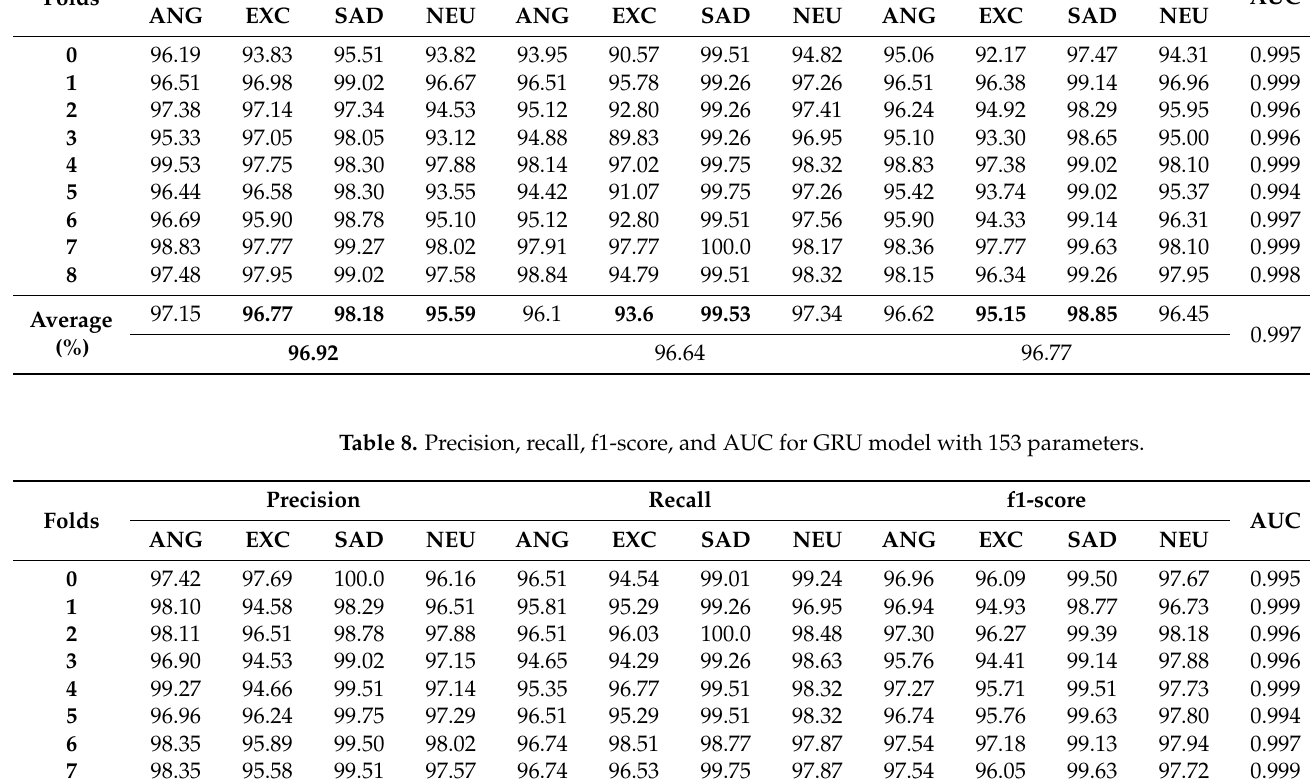
Table 7. Precision, recall, f1-score, and AUC for CRNN model with 153 parameters. Precision Folds